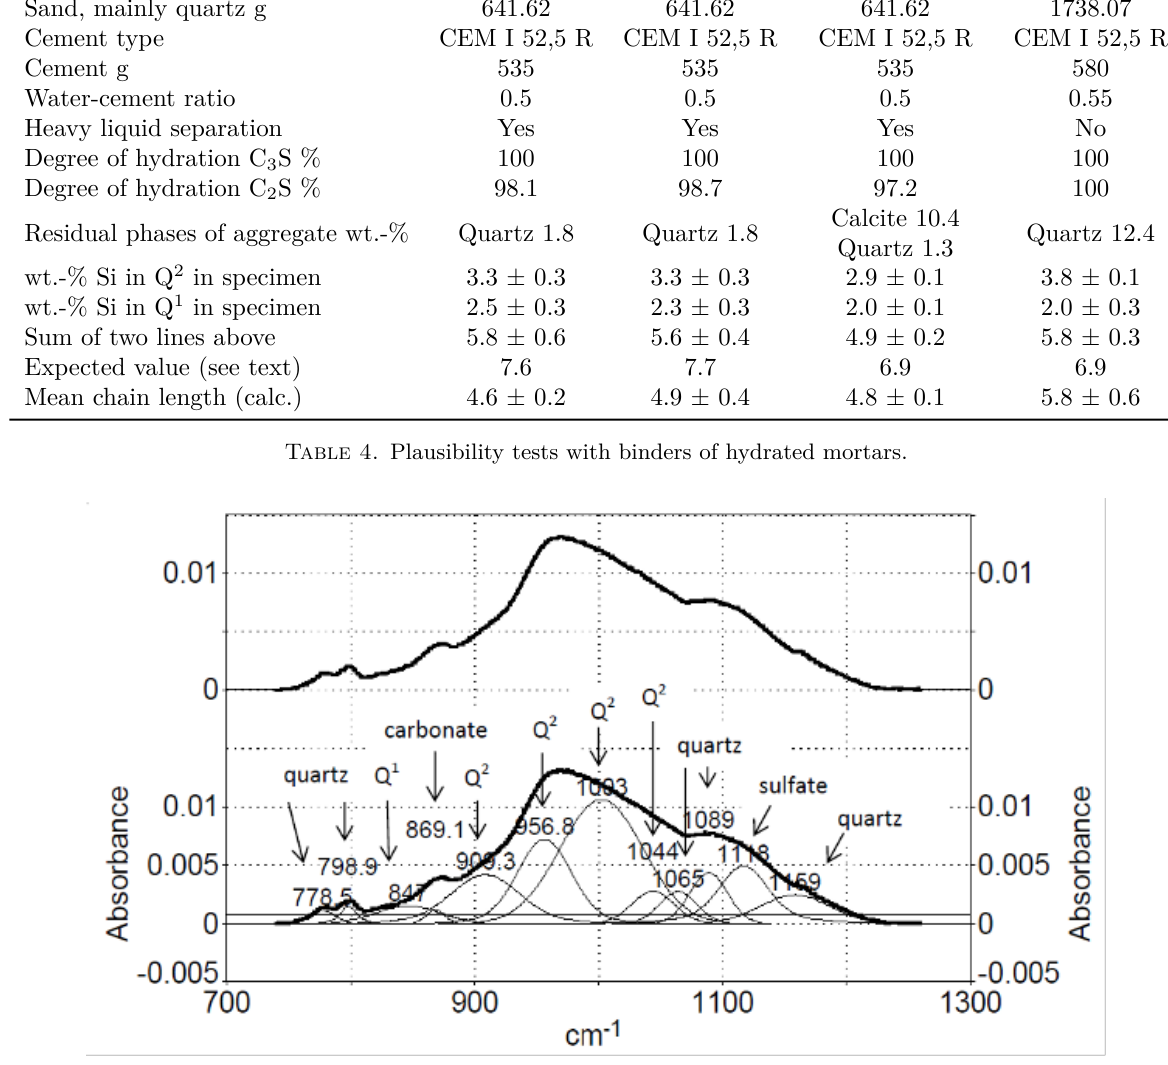
Figure 3. ATR-IR spectrum including the peak fit of a mortar with quartz aggregate and enrichment of the binder by grinding and sieving, showing the peaks of the Q 1 and the Q 2 structural units in the C-S-H. Background (logarithm function) subtracted before, leaned on the minima at the end of the displayed range.